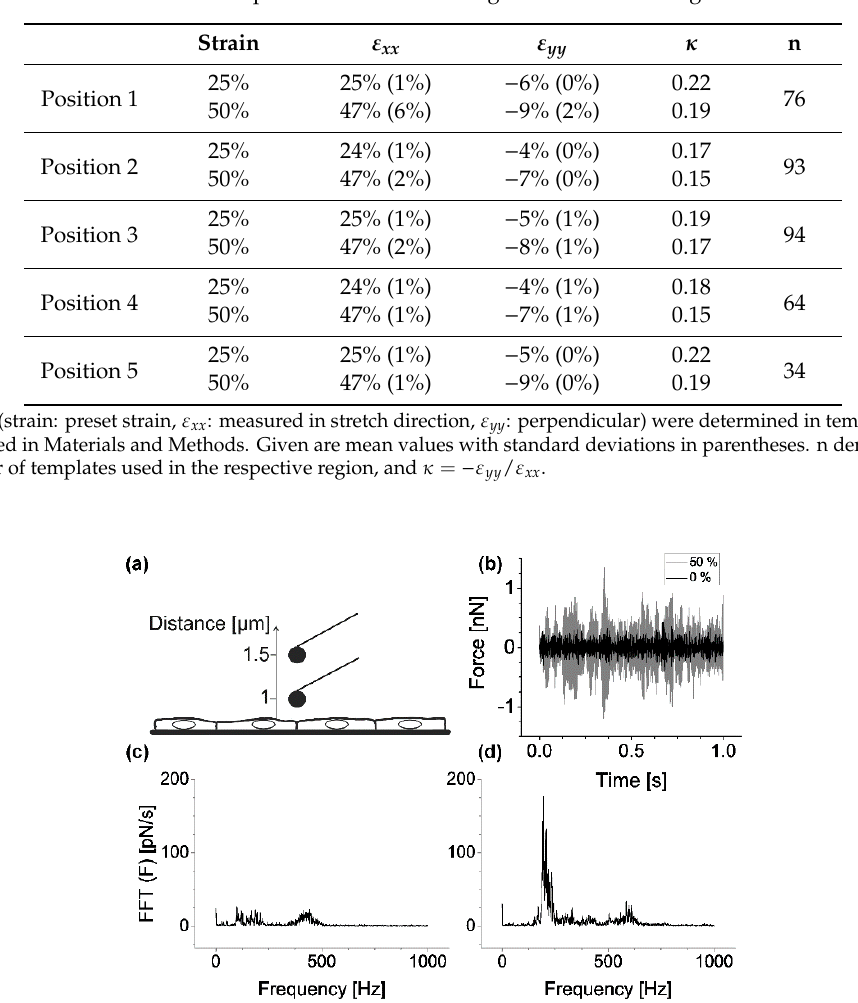
Table 1. Principle strains within the regions indicated in Figure 2.